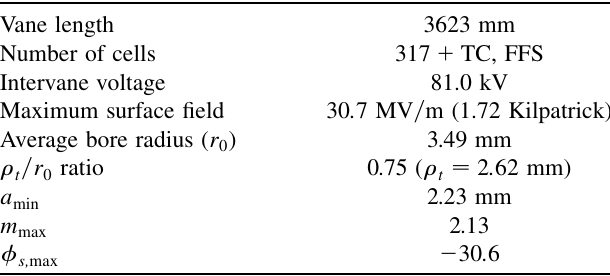
TABLE II. Design parameters of J-PARC RFQ III obtained with LINACSrfqDES. In this table, TC and FFS mean transition cell [19] and fringe-field section [20], respectively.